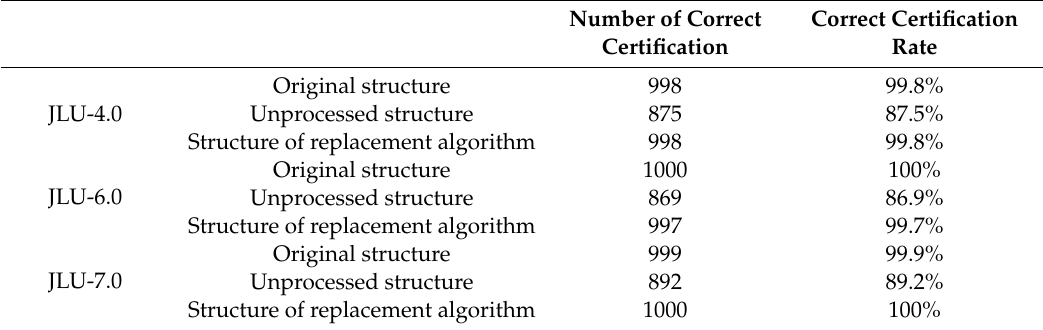
Table 6. The number of comparison times and recognition